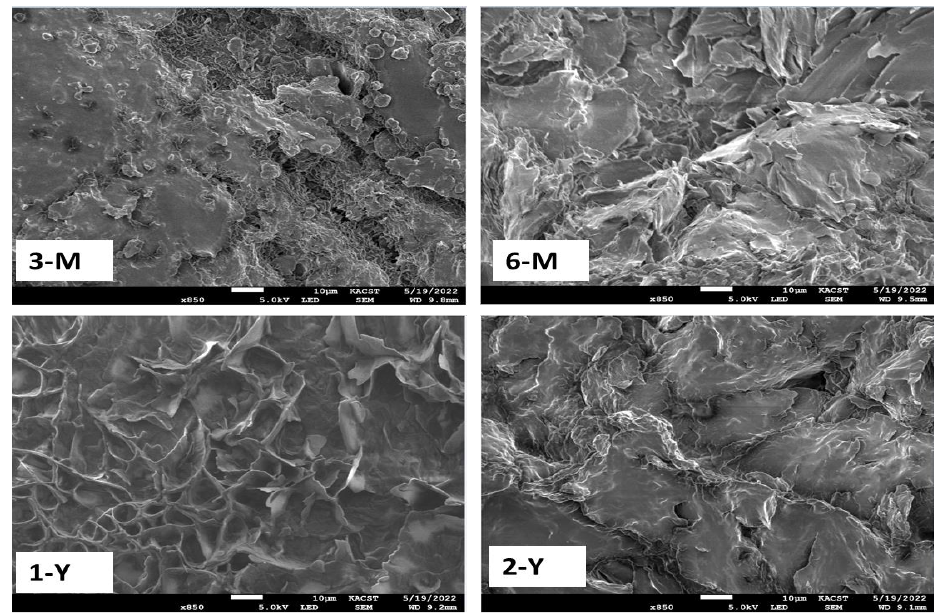
Figure 6. SEM micrographs of four BW samples with different storage times .